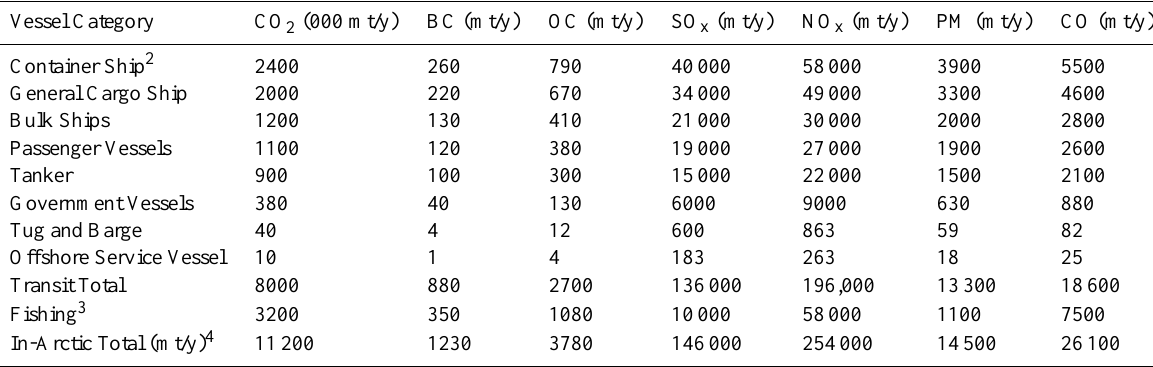
Table 3. In-Arctic shipping emissions estimates by vessel type 2004 (mt/y) 1 Vessel